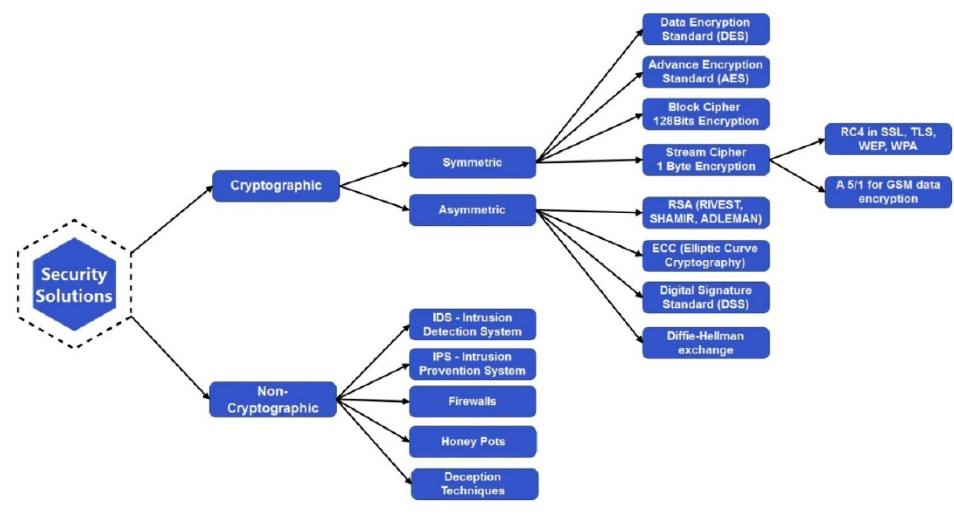
Figure 6. Security Solution based on Cryptosystems.